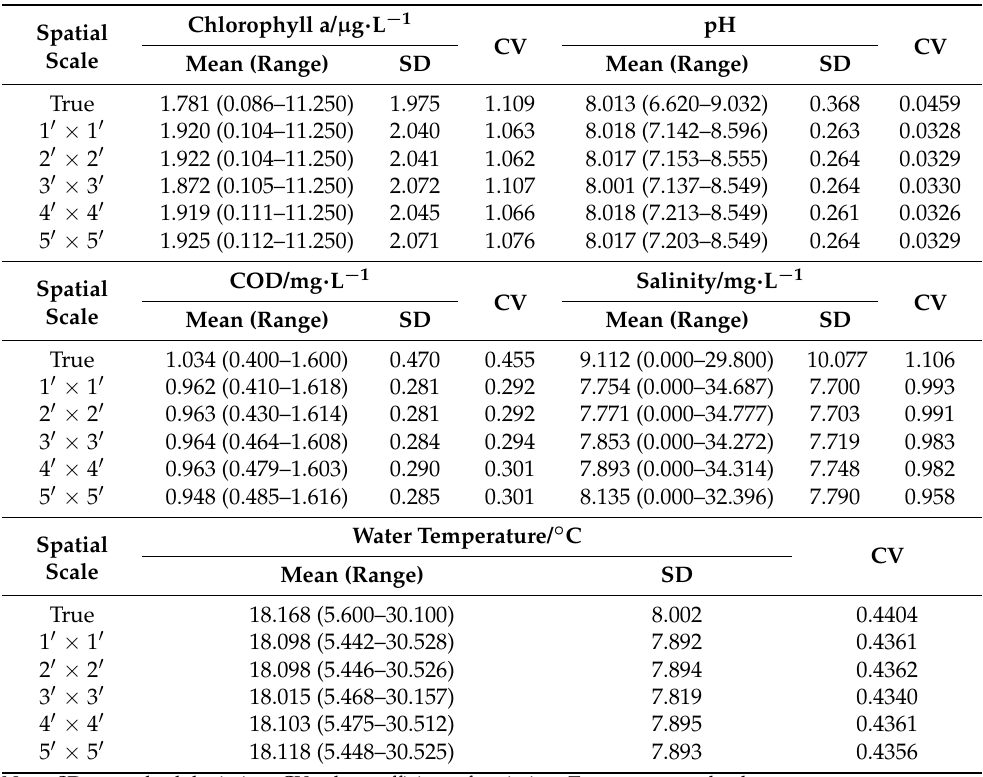
Table 3. Descriptive analysis of environment variables in different spatial interpolation methods.